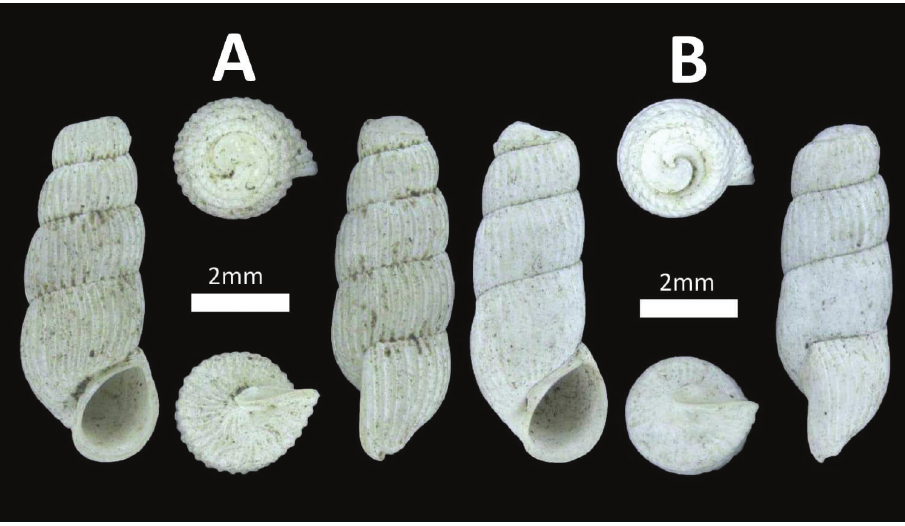
Figure 6. Family Truncatellidae. A Truncatella guerinii (BOR/MOL 12333) B Truncatella marginata (BOR/MOL